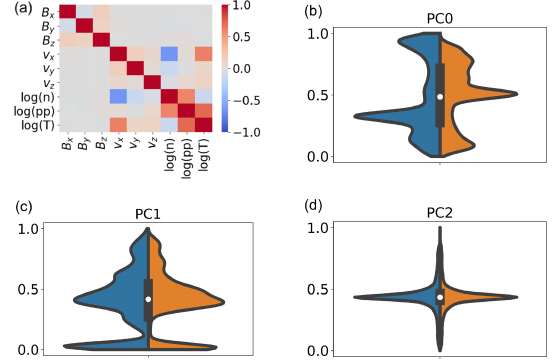
Figure 3. Correlation plot for the fixed time training data set at time t 0 + 210min (a) . Violin plots of the first three PCs after PCA for the fixed (left; blue half-violins) and mixed (right; orange half-violins) time data sets (b–d) are